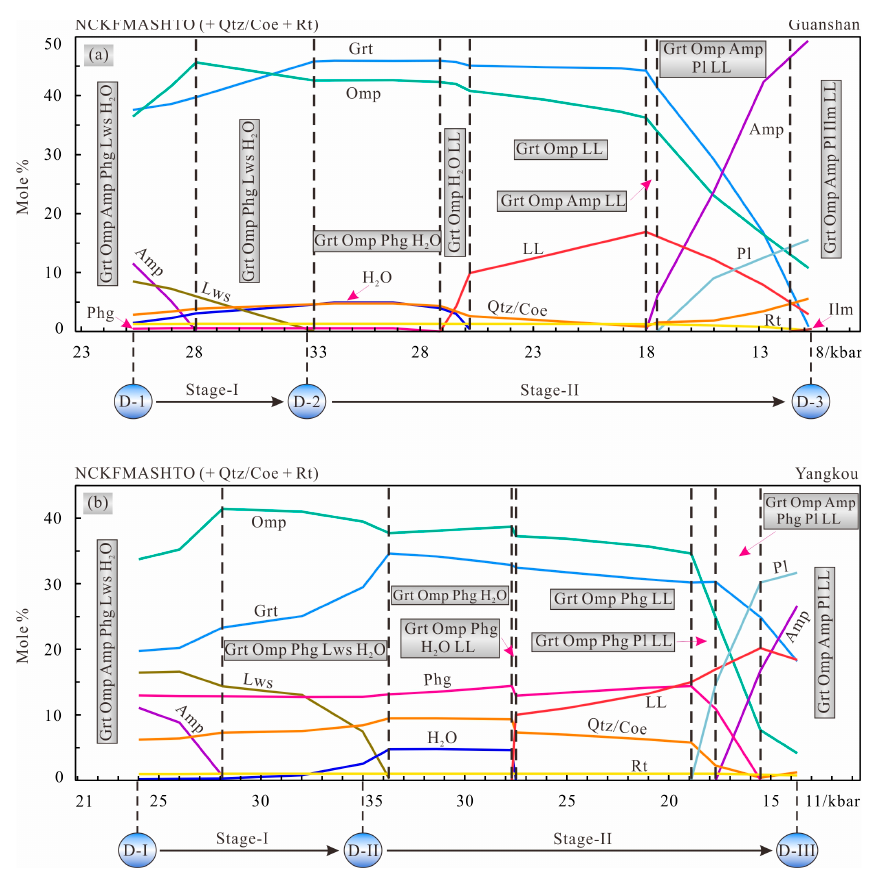
Figure 12. Computed modal variations of major minerals and H 2 O contained in the rock system along the P-T path for the Guanshan eclogites ( a ) and Yangkou eclogites ( b ).